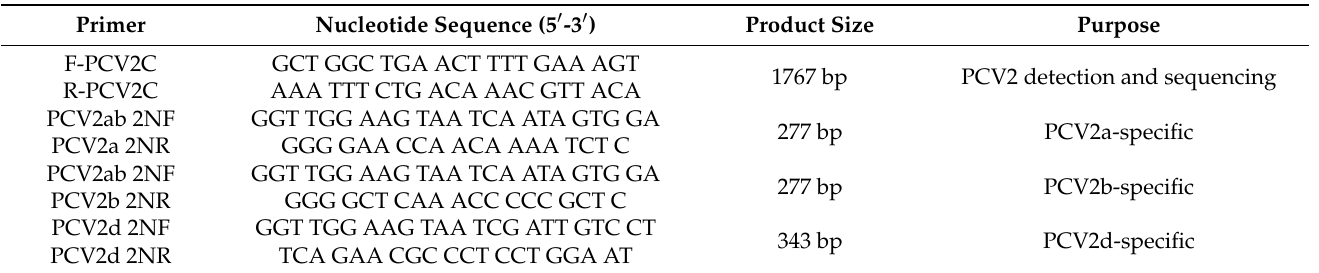
Table 1. Primers used in this